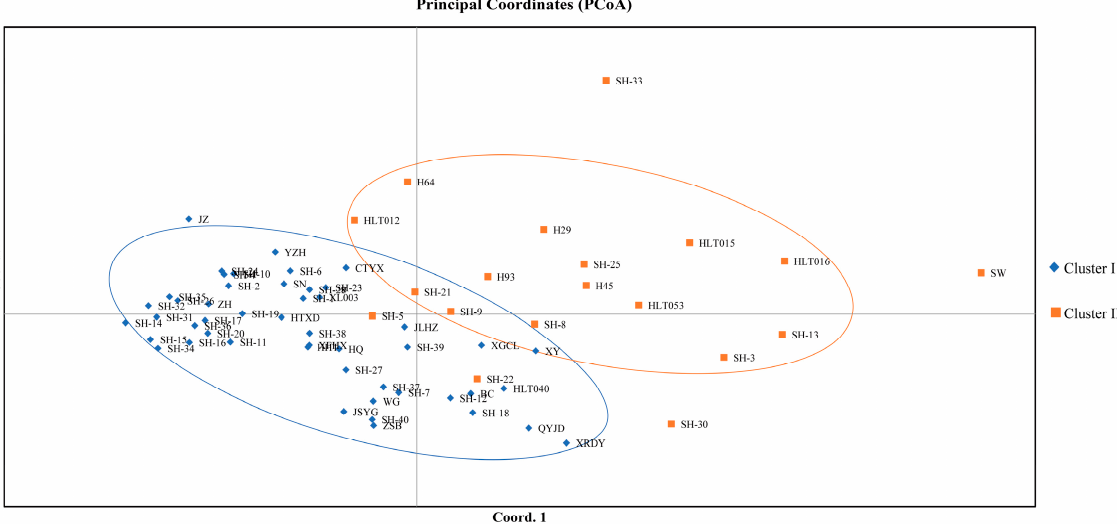
Figure 8. PCA analysis of 69 wintersweet cultivars and genotypes based on structural analysis.